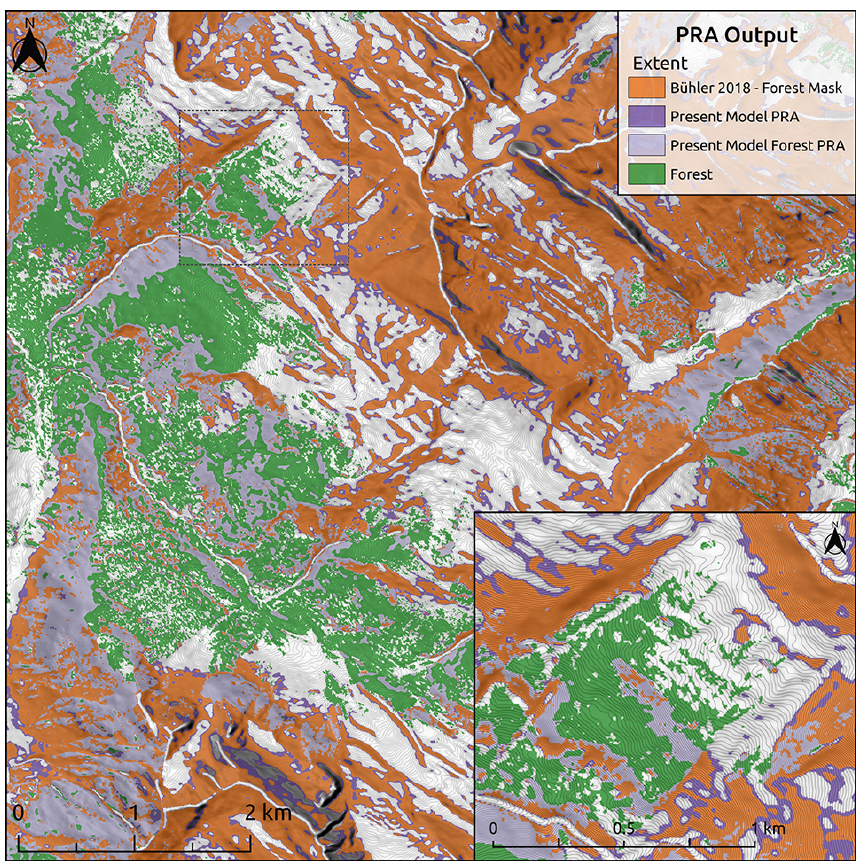
Figure 12. Comparison of present PRA model to “Bühler 2018 – forest mask”. Present model PRA area is dark purple with light purple for forested areas. “Bühler 2018 – forest mask” is shown in orange for comparison. Inset map shows detailed PRA comparison on a local scale; extent shown by dotted black line. Forest data created using Planet Labs RapidEye imagery (Planet Team,